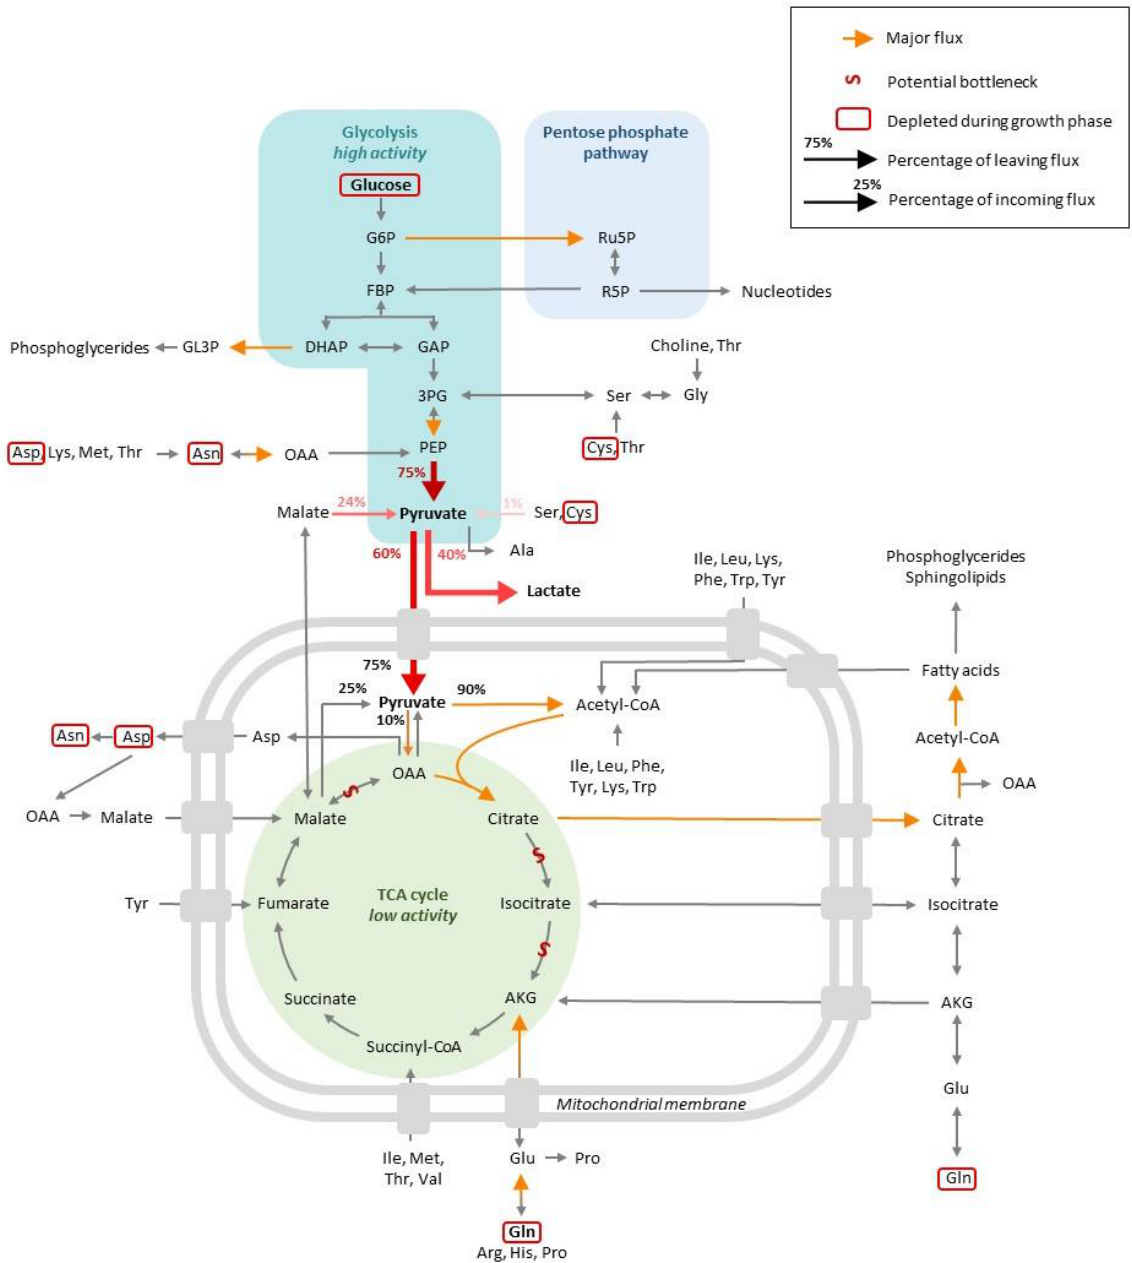
Figure 1. Global view of the central CHO cell metabolism at the exponential phase of growth.